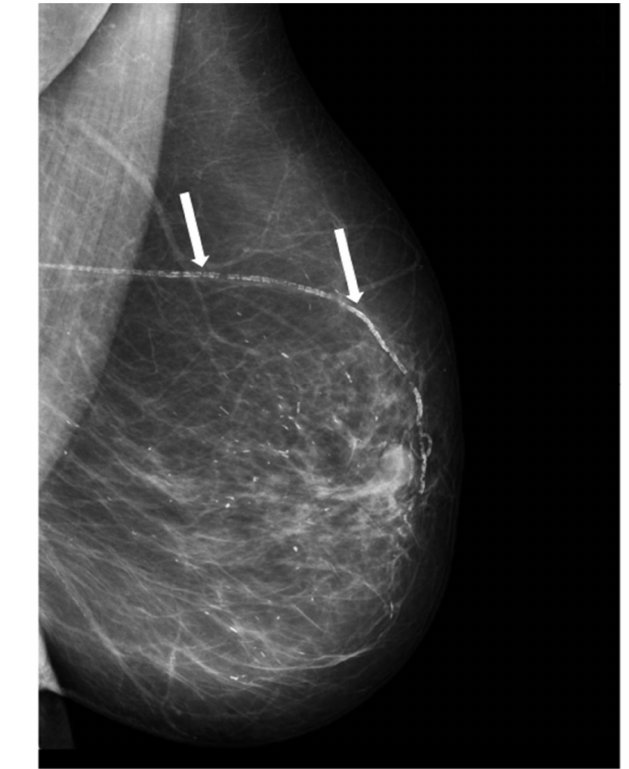
Figure 1. Mammogram showing breast arterial calcifications